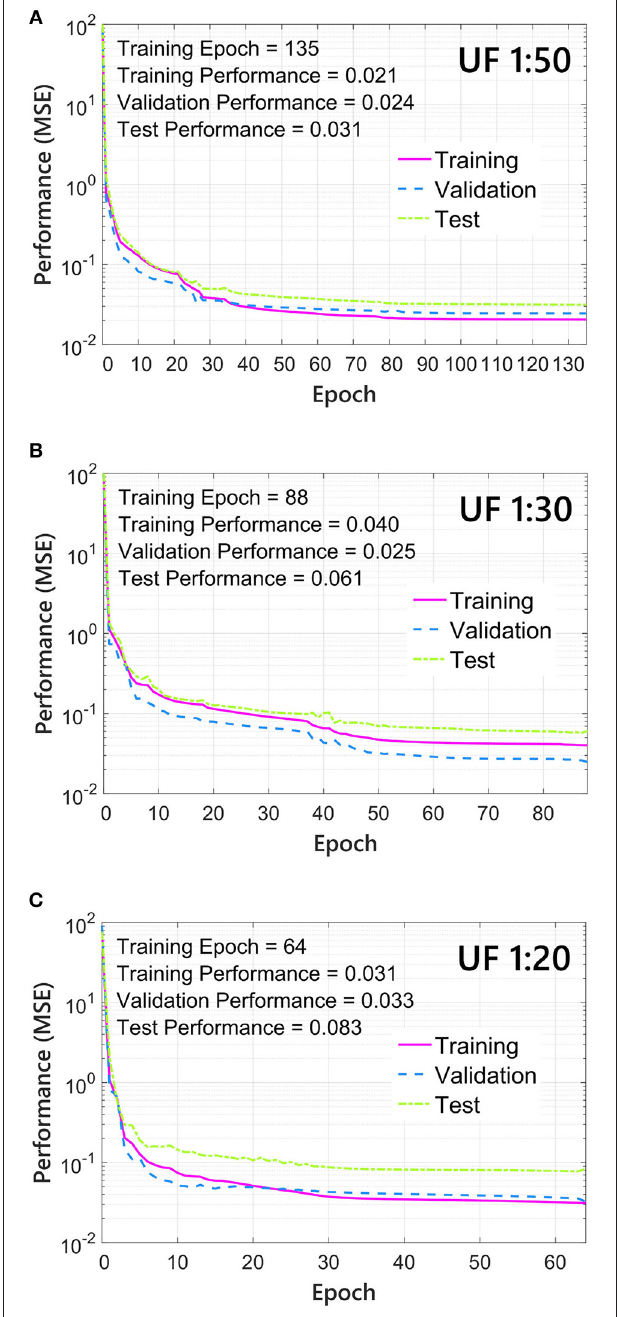
FIGURE 6 | ANN backpropagation performance history for training, validation, and testing subsets: (A) 1:50, (B) 1:30, and (C) 1:20 building models.